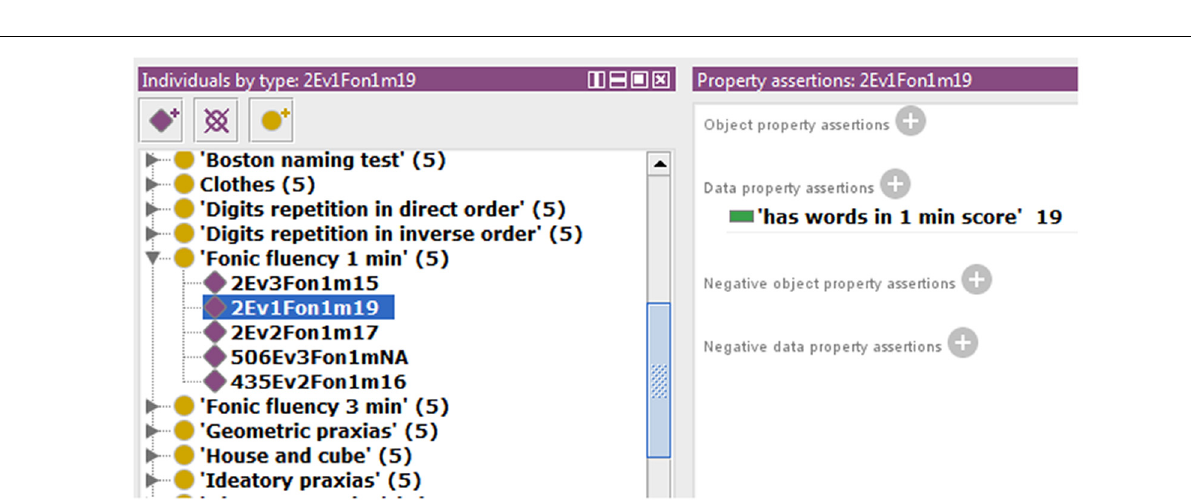
FIGURE 3 | Example of an inconsistency in the instantiation detected by the HermiT reasoner.